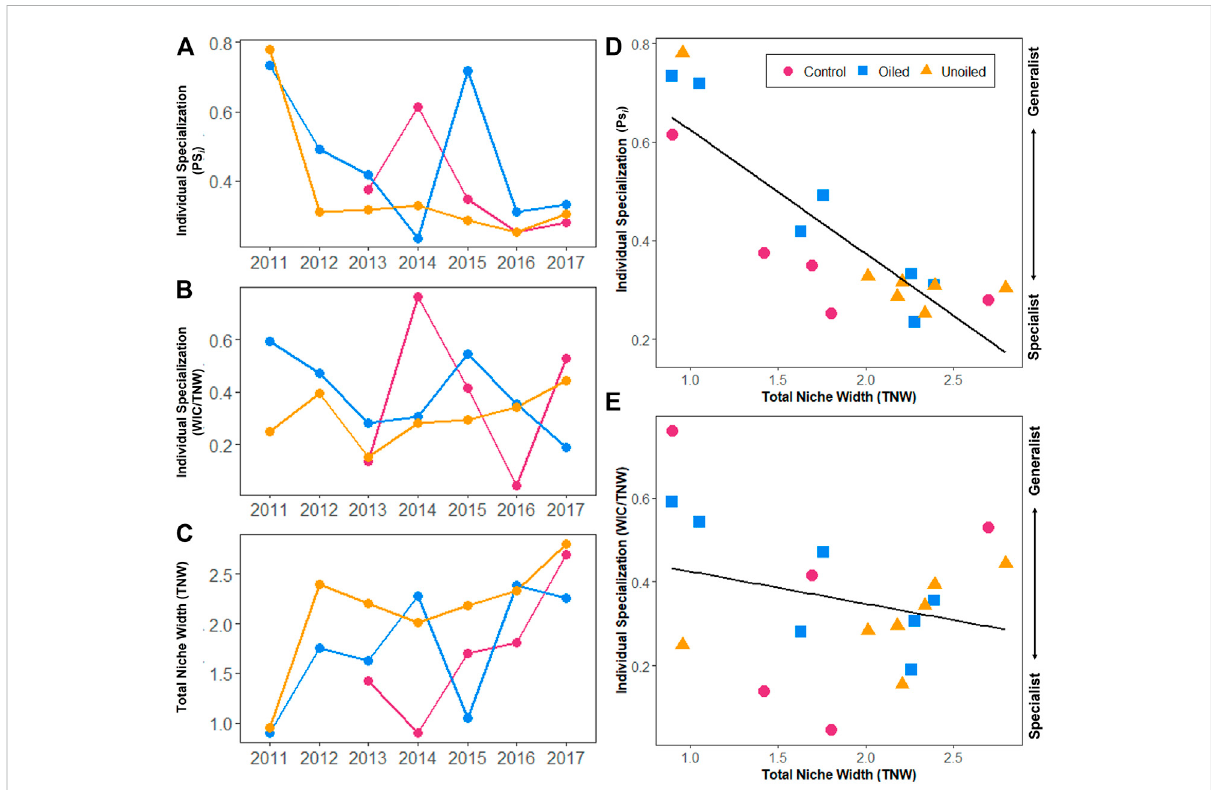
FIGURE 4 Individual specialization (IS), calculated by PSicalc (A) and WIC/TNW (B) , was most stable on unoiled sites throughout time, as was total niche width (TNW), (C) . There is a strong correlation between TNW and IS (when is calculated by PSicalc ), meaning as a sample group ’ s TNW increases, individuals become more specialized (D) . As IS values approach one, the more individual diet overlaps with the population, where one represents complete overlap. As the values approach zero, the less an individual ’ s diet overlaps with the population and the more specialized individuals are. However, when IS calculated by WIC/TNW, there is no signi fi cant correlation with TNW (E)